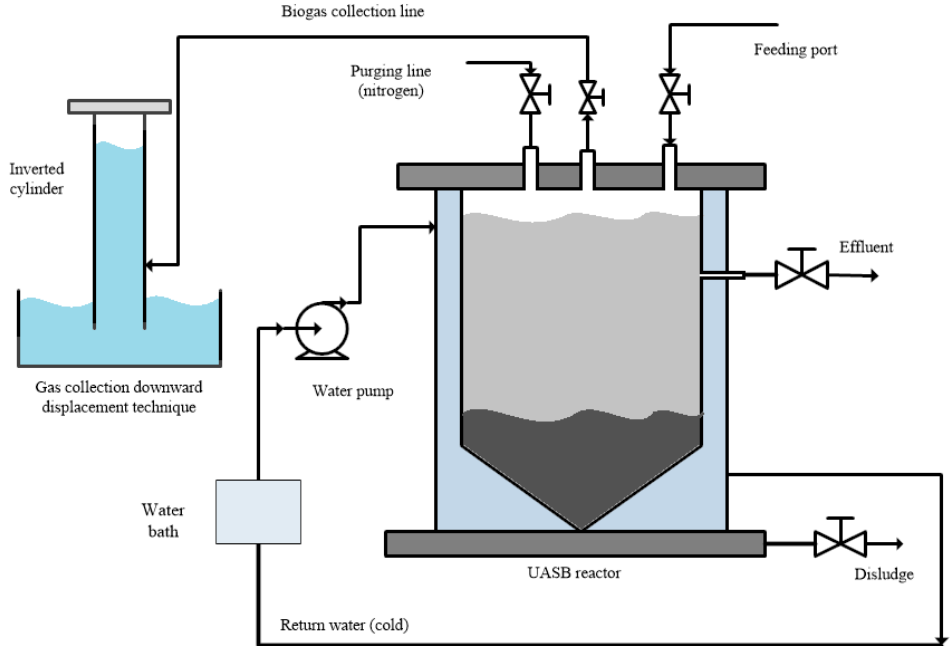
Figure 1. An experimental setup consisting of the UASB reactor and the downward displacement gas collection technique.